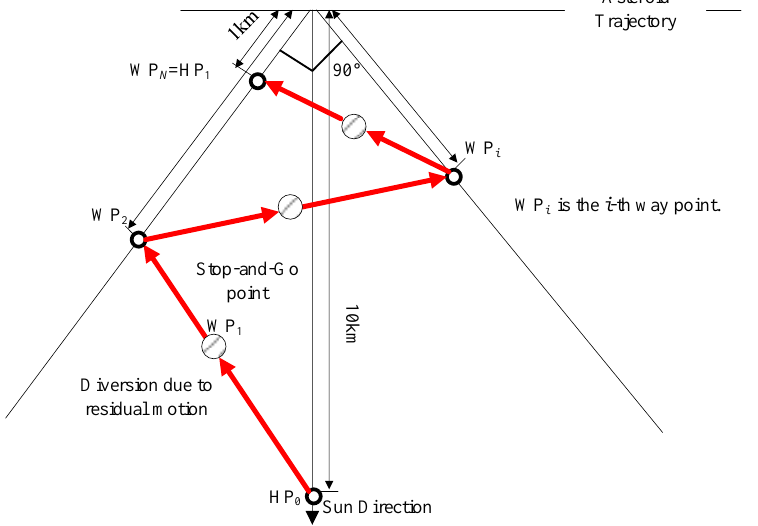
Figure 5. During the “ stop ” period, the residual motion of the spacecraft will cause a certain drift.